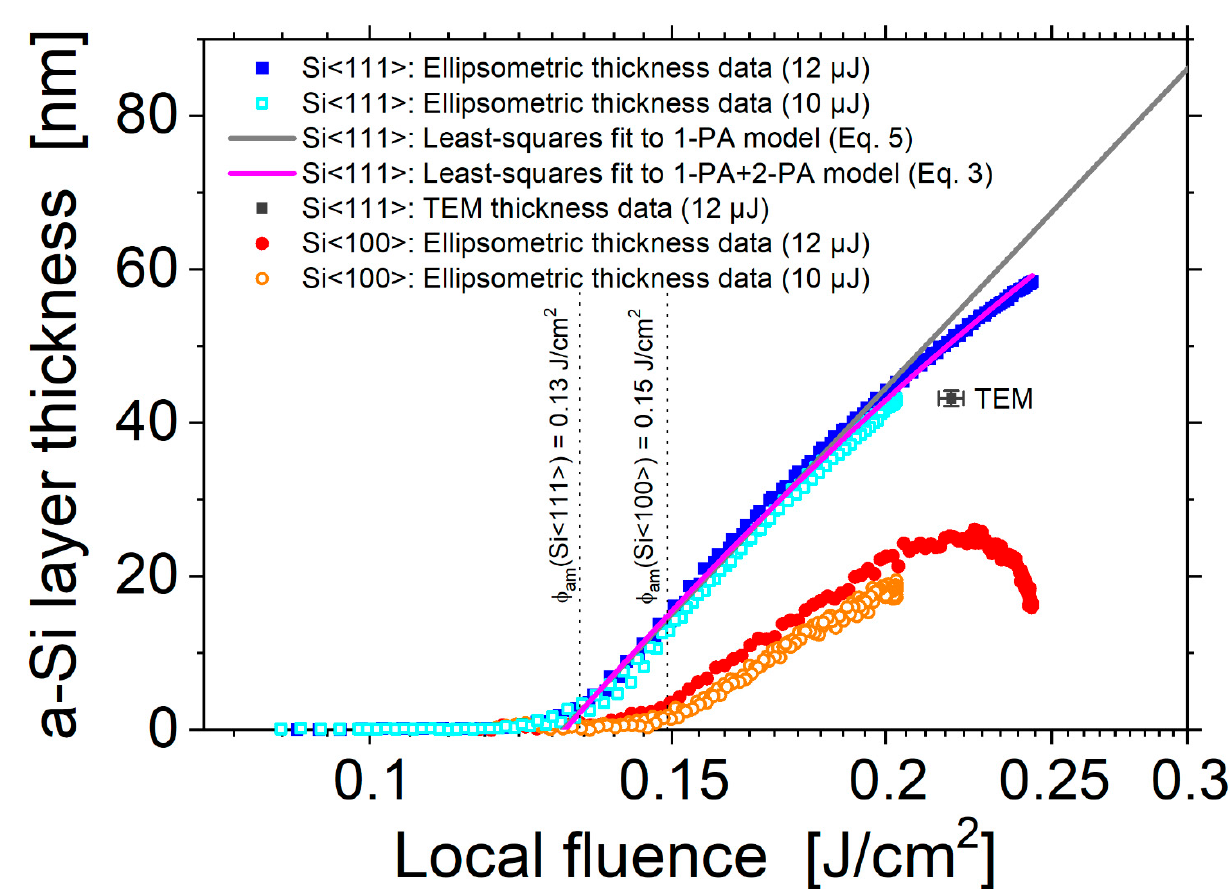
Figure 9. Amorphous layer thickness d am versus local laser fluence φ . The data points are obtained from SIE measurements at the four different fs-laser-irradiated spots analyzed previously in Figure 4 for Si<111> (blue full squares (12 µJ) and cyan open squares (10 µJ)) and for Si<100> (red full circles (12 µJ) and open orange circles (10 µJ)). A quantitative measurement by TEM is indicated as a single black square with its respective uncertainties. The two vertical dashed lines indicate the corresponding amorphization thresholds of both silicon materials as previously deduced by OM. The solid pink and solid gray lines are least-squares fits to Equations (3) and (5), respectively.